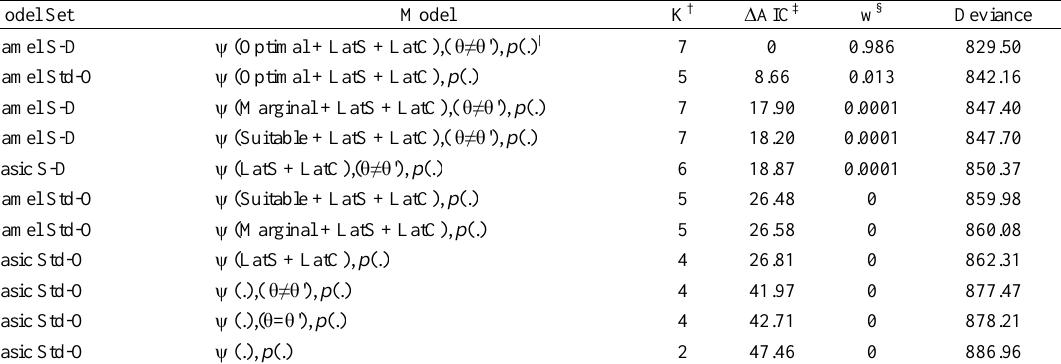
Table 3. Model selection results for Brown-headed Nuthatch ( Sitta pusilla ) occupancy models in the South Atlantic Coastal Plain, United States, 2001. Occupancy ( ψ ) was modeled as constant (.), as a function of latitude (LatS = 29-31°, LatC = 32-34° N, LatN = 35-37° N) and Hamel’s habitat suitability categories, namely, optimal (O), suitable (S), and marginal (M). Detection probability ( p ) was modeled as constant (.). Models account for spatial correlation within segment stations ( θ = θ ` or θ ≠ θ `). The term Basic Model means that occupancy ( ψ ) was not constrained by a covariate, or constrained by latitude. S-D means spatial dependence model structure; Std-O means standard occupancy model structure. LatN defaults to the intercept in the model parameterization. N = 480 route